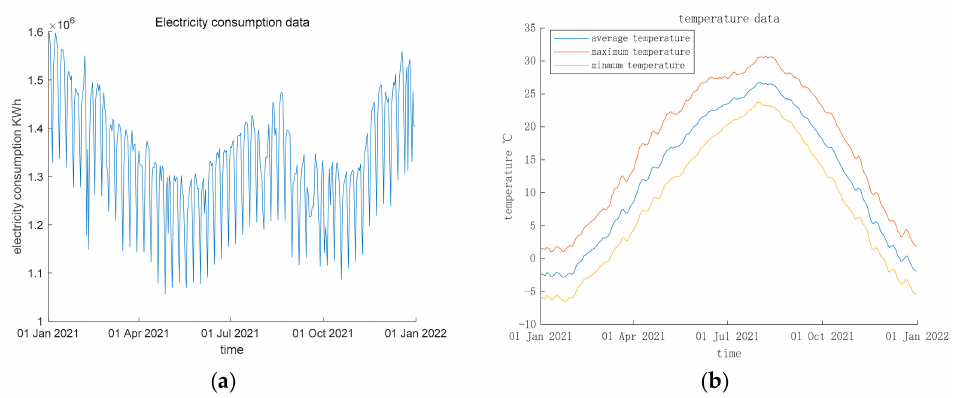
Figure 5. Load and temperature change in 2021. ( a ) Urban daily load change curve in 2021; ( b ) Tem- perature change curve of a city in